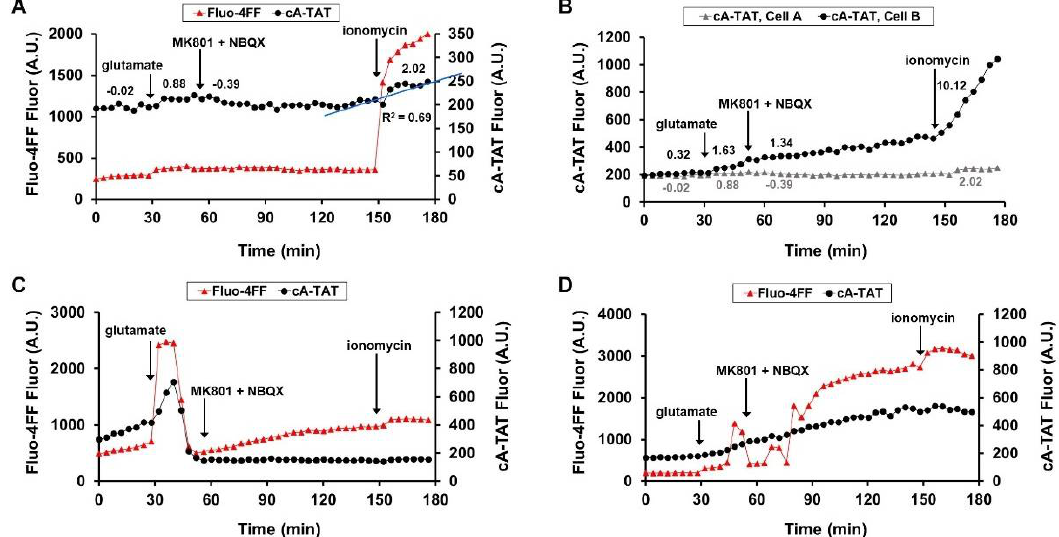
Figure A1. Examples of cells excluded from analysis based on the exclusion criteria. The representa- tive cell in ( A ) was excluded because the noise-to-signal ratio of the cA trace precluded a linear fit. The numbers above the traces show the rates calculated by linear regression analysis. “Noise-excluded” cells typically had an unstable or negative baseline, precluding normalization, and showed little-to-no ionomycin response (R 2 < 0.7). ( B ) The cA-TAT fluorescence (fluor) time course for the representative cell shown in A, “Cell A”, is plotted on the same scale and compared to that of the representative cell that was plotted in Figure 4E, “Cell B.” ( C ) An example of a cell that underwent lysis about 15 min after glutamate addition. Note the rapid loss of both Fluo-4FF and cA-TAT fluorescence probes at around the 45 min mark upon plasma membrane rupture. ( D ) An example of a cell that underwent reversible Ca 2+ deregulation following glutamate exposure. Note the elevation of Fluo-4FF signal at around the 45 min mark that subsequently recovered upon addition of glutamate receptor antagonists MK-801 and NBQX. Sustained DCD then occurred at about the 80 min mark. Cells that spontaneously underwent Ca 2+ deregulation prior to glutamate addition (not shown) showed an abrupt jump in Fluo-4FF signal similar to that of the DCD cell depicted in Figure 4D (which occurred at the 60 min mark), except that in these cells the jump occurred within the first 30 min of imaging, prior to the addition of